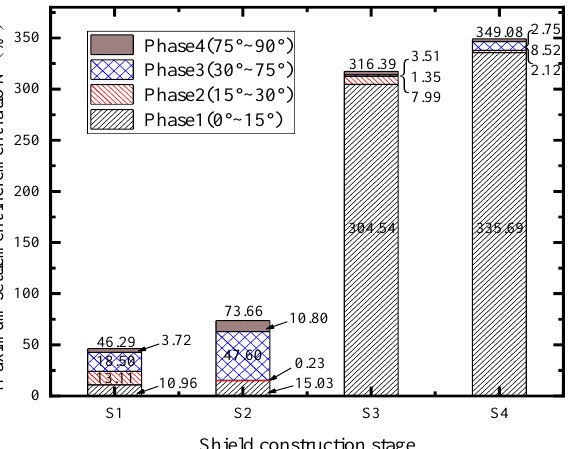
Figure 21. Maximum settlement increment ratio of the existing tunnel under different construction stages.